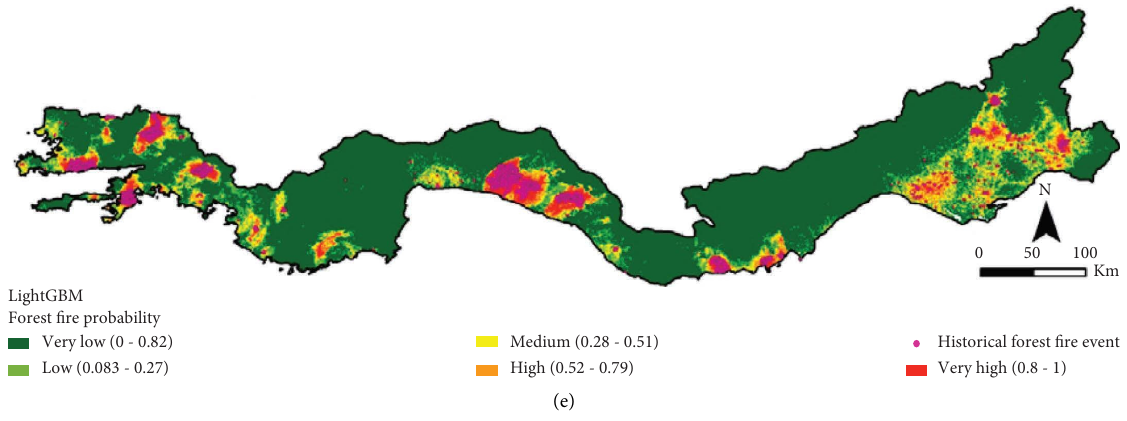
Figure 7: Result maps of all the models: (a) XGBoost, (b) CatBoost, (c) GBM, (d) AdaBoost, and (e) LightGBM.